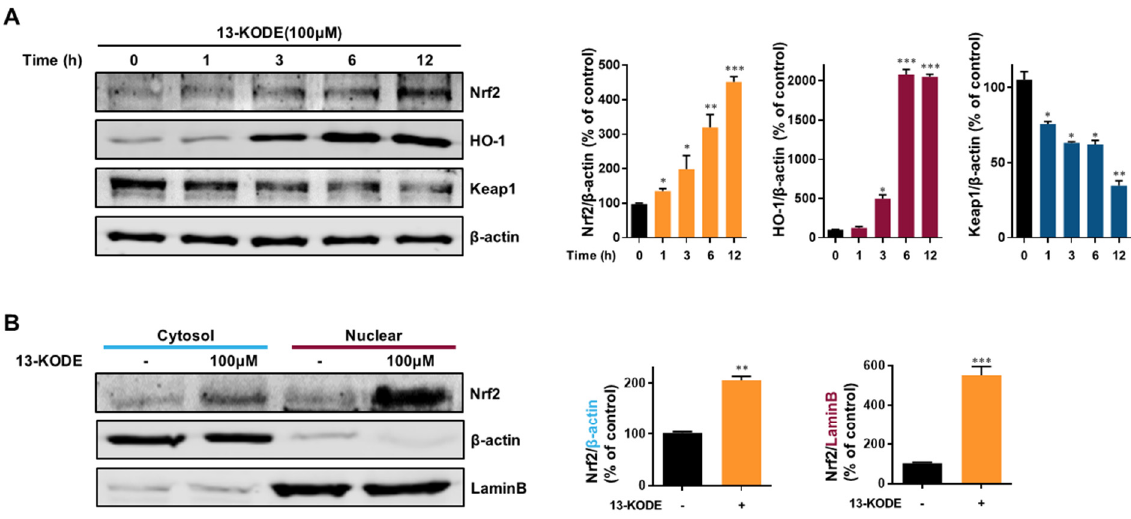
Figure 7. Induction of Nrf2 (Nfe2I2) and HO-1 proteins by 13-KODE in RAW 264.7 cells. ( A ) Mac- rophage cells were cultured with 100 µM 13-KODE for the indicated times. Total protein was iso- lated by 10% SDS-PAGE and transferred to PVDF membranes. The membranes were probed with the indicated antibodies. β -Actin served as the internal control. ( B ) Macrophage cells were treated with 100 µM 13-KODE for 12 h. Nuclear and cytosolic proteins were probed with anti-Nfe2I2 (Nrf2) antibody. Proteins were visualized using the near-infrared (NIR) Western blot system. Lamin B and β -actin were used as internal controls for the nuclear and cytosolic proteins. The values represent the mean ± standard deviation, n = 3. * p < 0.05; ** p < 0.01; *** p <